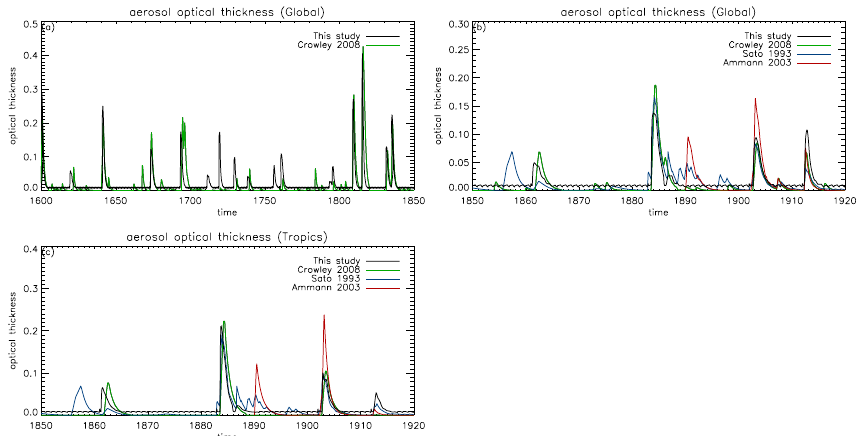
Fig. 11. Global mean total optical depth (AOD) in VIS (550nm) for (a) 1600–1850 and (b) 1850–1920. Tropical mean AOD for 1850–1920 (c) . Black line is the AOD from this study, green line is the AOD from Crowley et al. (2008), blue line is the AOD of Sato et al. (1993), red line is from Ammann et al. (2003).